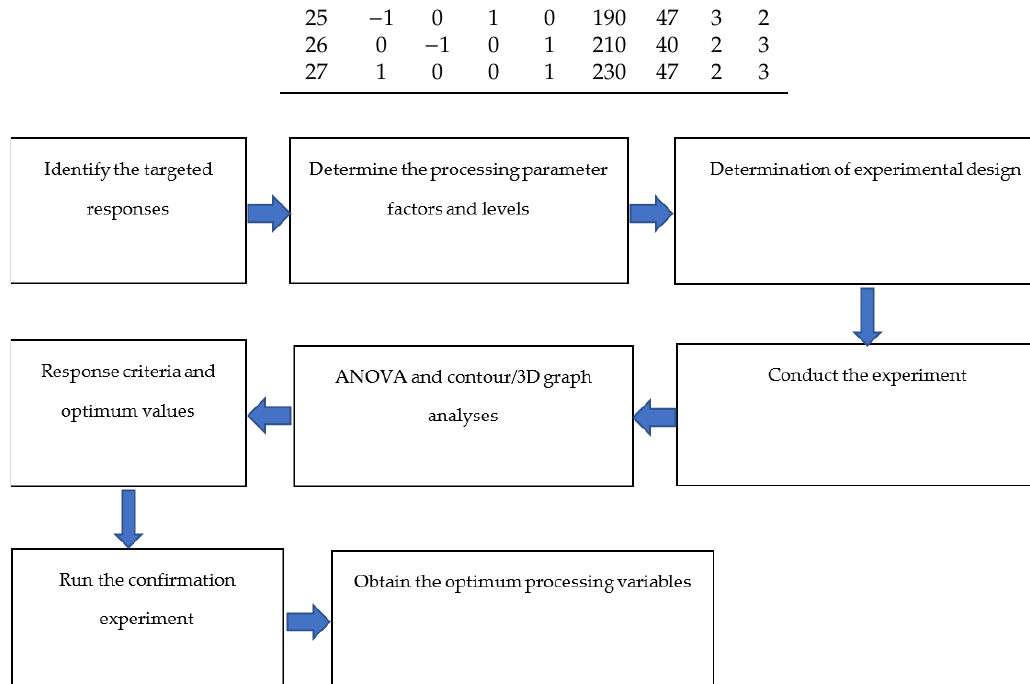
Table 2. Processing factors and levels.